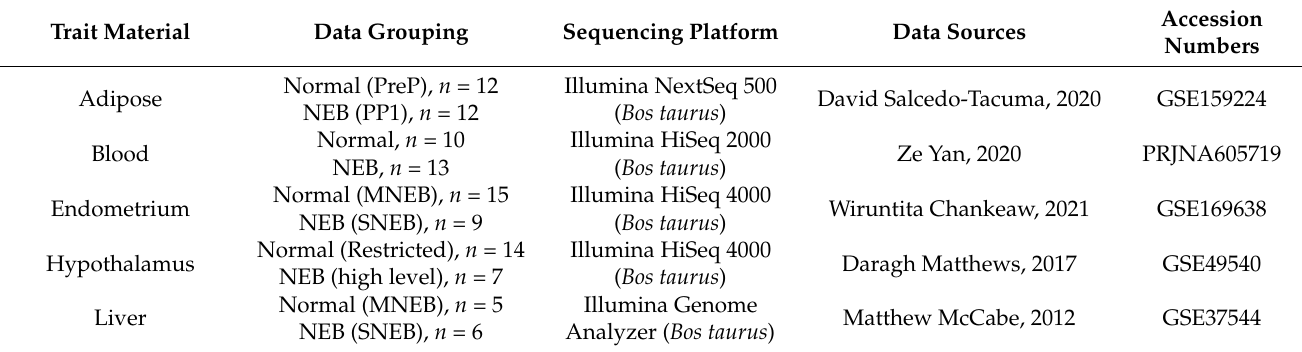
Table 1. Detailed information about the RNA-seq